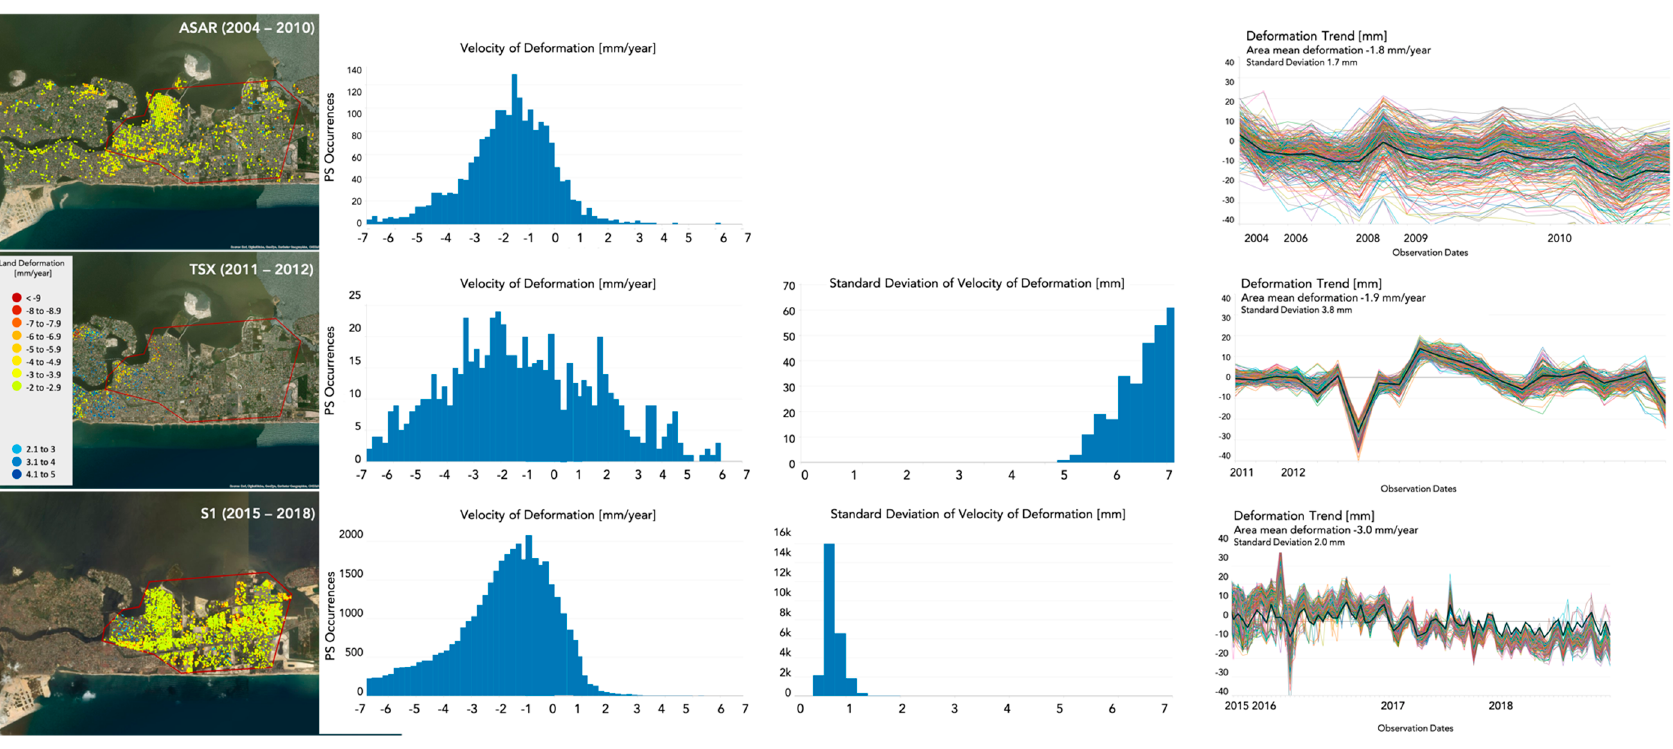
F igure 7. Lagos AOI 2. Figure 7. Lagos AOI